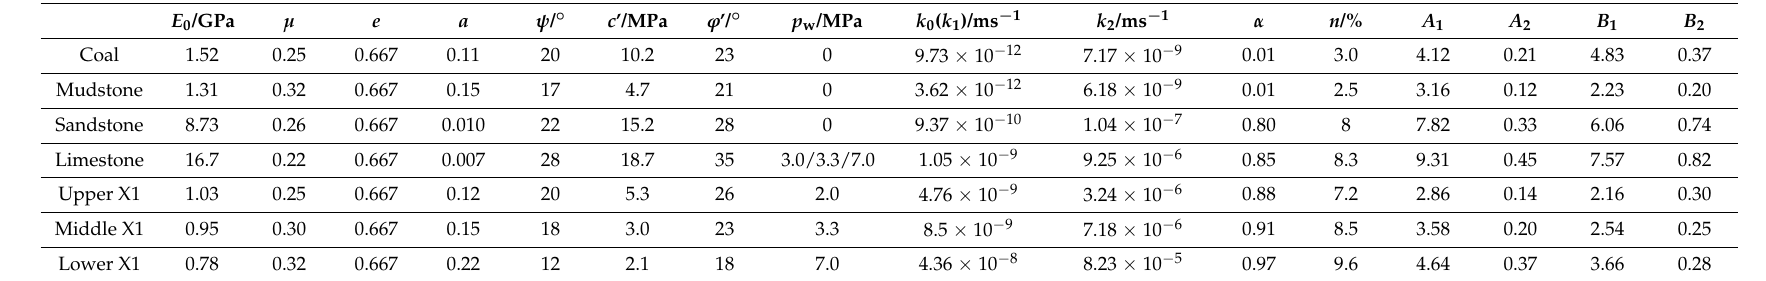
Table 4. Material parameters (rock